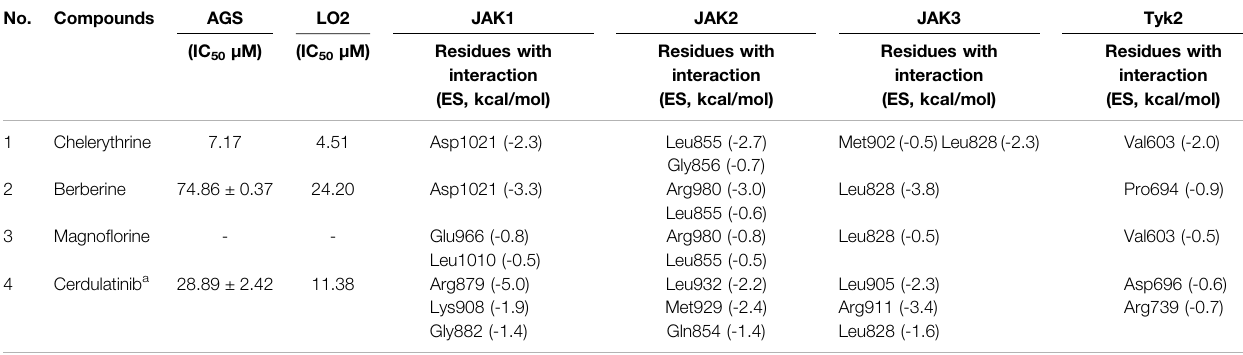
TABLE 2 | The IC50, and docking results of selected potential